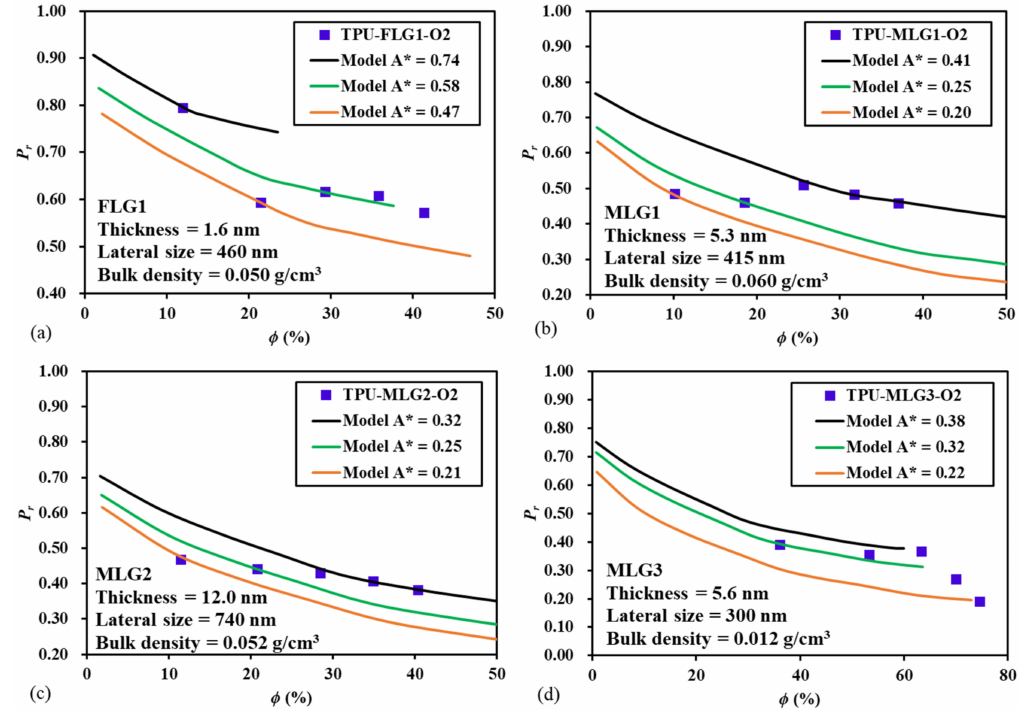
Figure 11. Comparison of the experimental data of Zahid et al. [25] and the prediction of the proposed model for the relative permeability of the oxygen transport across four types of MMMs consisting of thermoplastic polyurethane (TPU), embedding few-layer (FLG), and multi-layer (MLG) graphene